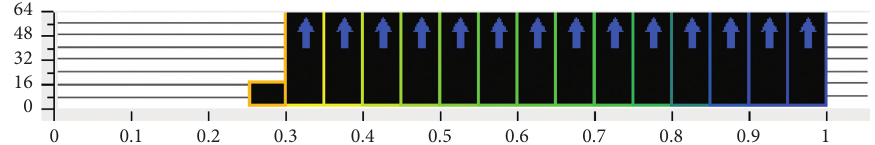
Figure 10: Grid quality inspection results.